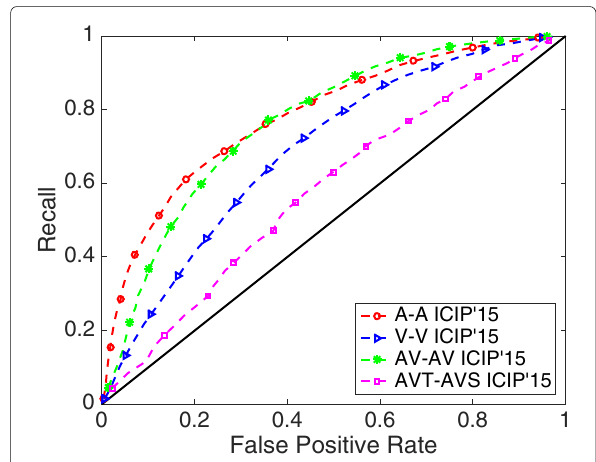
Fig. 13 Objective evaluation results for the five travel documentaries. Saliency classification ROC curves for the different modalities, using five fold cross-validation